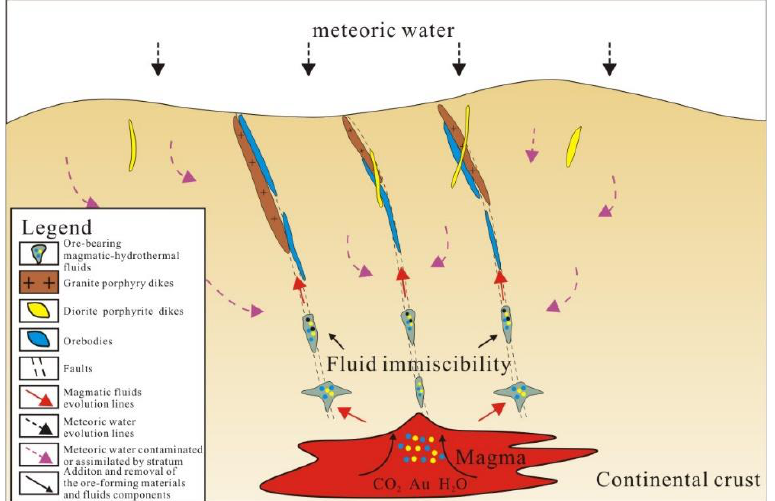
Figure 12. Simplified cartoon for the ore-forming model of the Toudaochuan deposit.